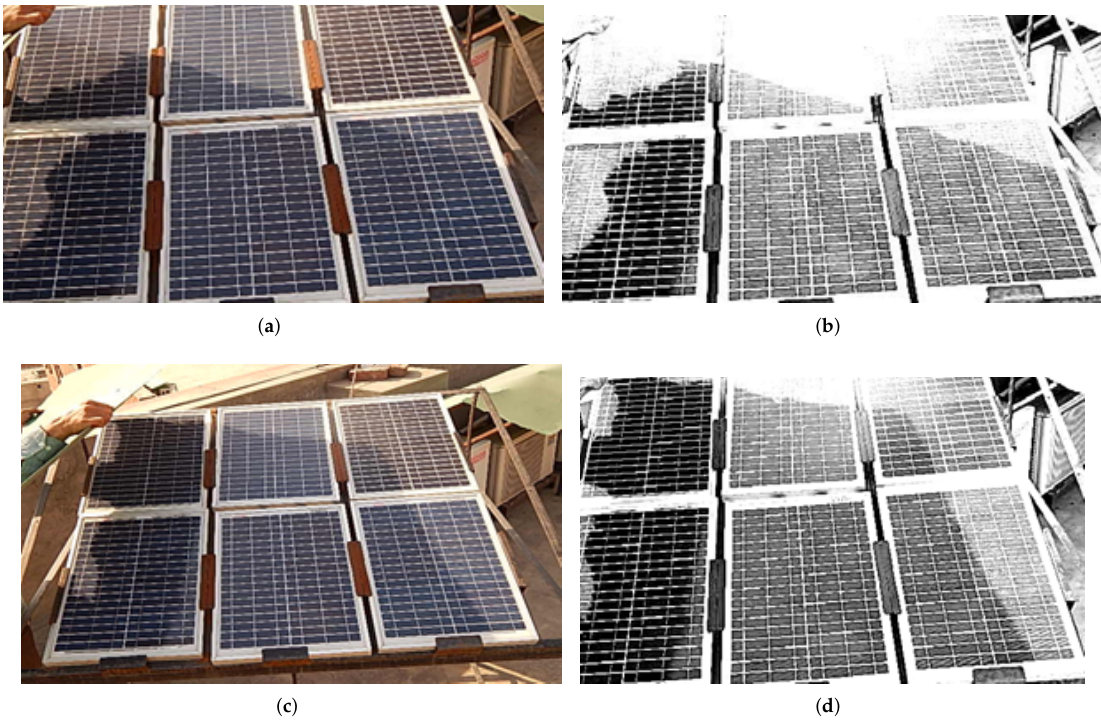
Figure 6. Image processing techniques in the MALTAB libraries. ( a ) Partial shading case 1, Ac- tual image. ( b ) Case 1, Processed image. ( c ) Partial shading case 2, Actual image. ( d ) Case 2, Processed